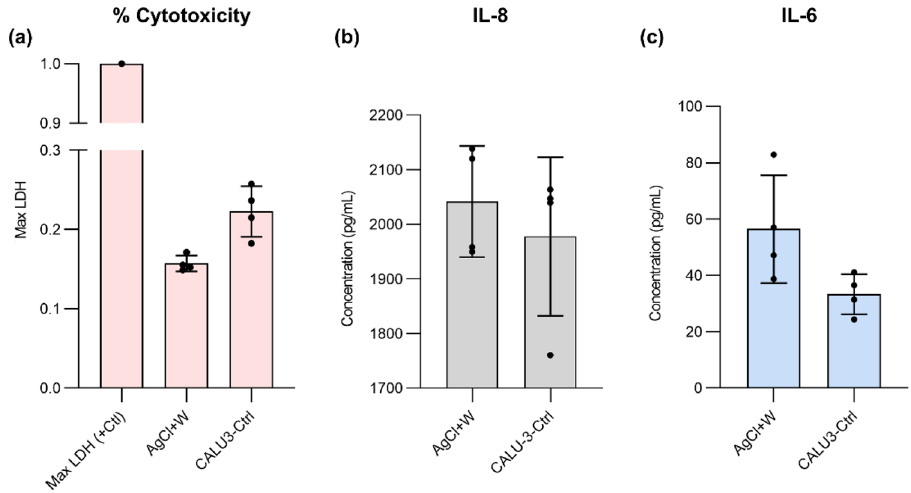
Figure 7. In vitro studies of wire format sensors placed in an array of macro wells: ( a ) cytotoxicity of wire- format sensors adjacent cells using LDH assay, ( b ) the production of IL-8, and ( c ) the production of IL-6. The error bars are standard